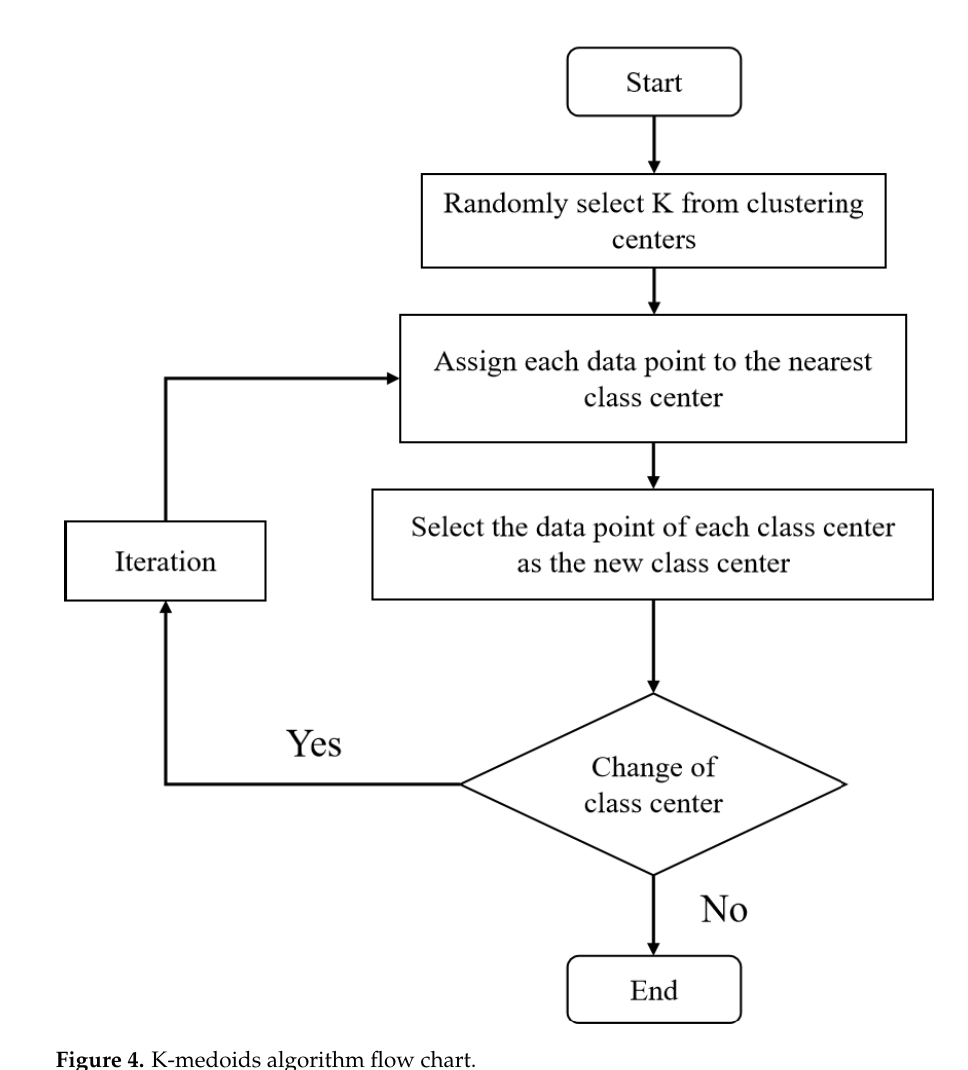
Figure 4. K-medoids algorithm flow chart.